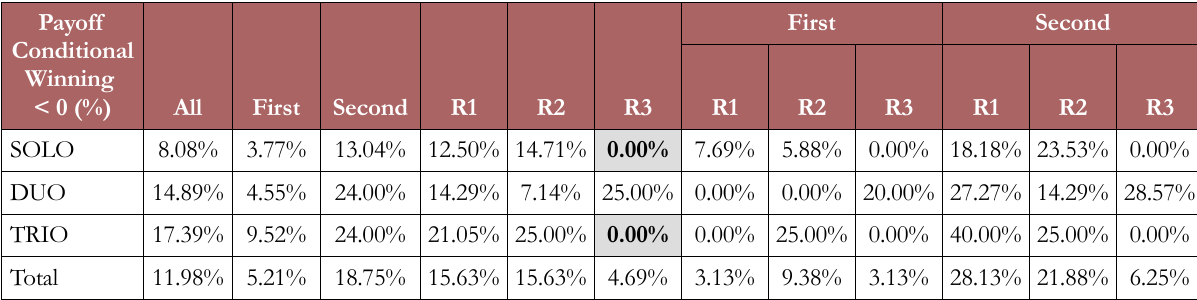
Table 7. Payoff Conditional on Winning < 0: pairwise differences in terms of size by right and mechanism